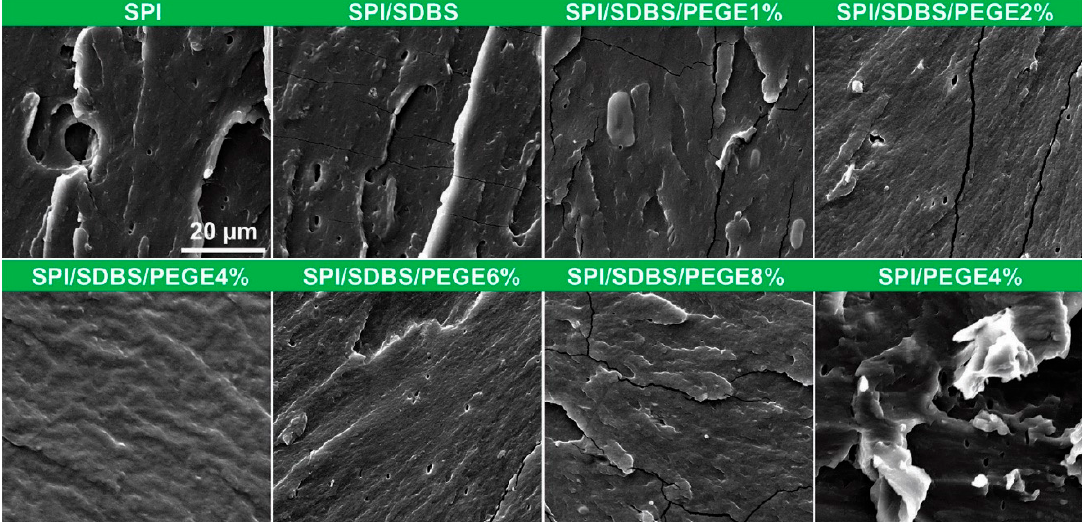
Figure 6. SEM images of cross-sections of the SPI-based films.